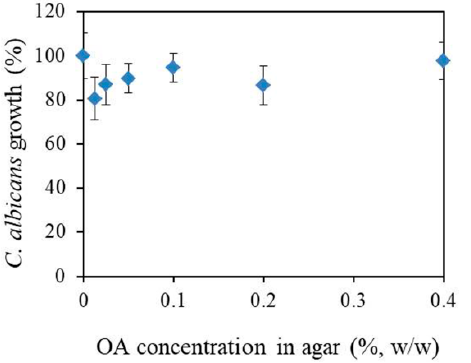
Figure 4. Oleic acid (OA) affection on the C. albicans growth 24 h of incubation in agar loaded with different oleic acid (OA) concentrations. Results are given as mean ± standard deviation percentages of A 620 readings compared to control (0% OA) as a function of OA concentration.